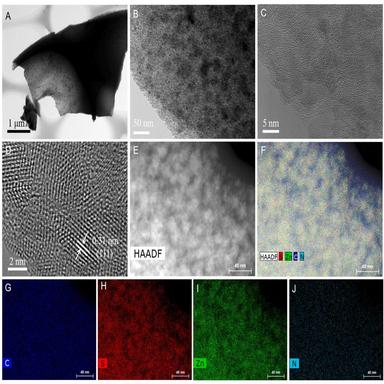
(A, B) TEM and (C, D) HRTEM images of ZnS/NC composite; (E-J) HAADF image and elemental mapping images of ZnS/NC composite.